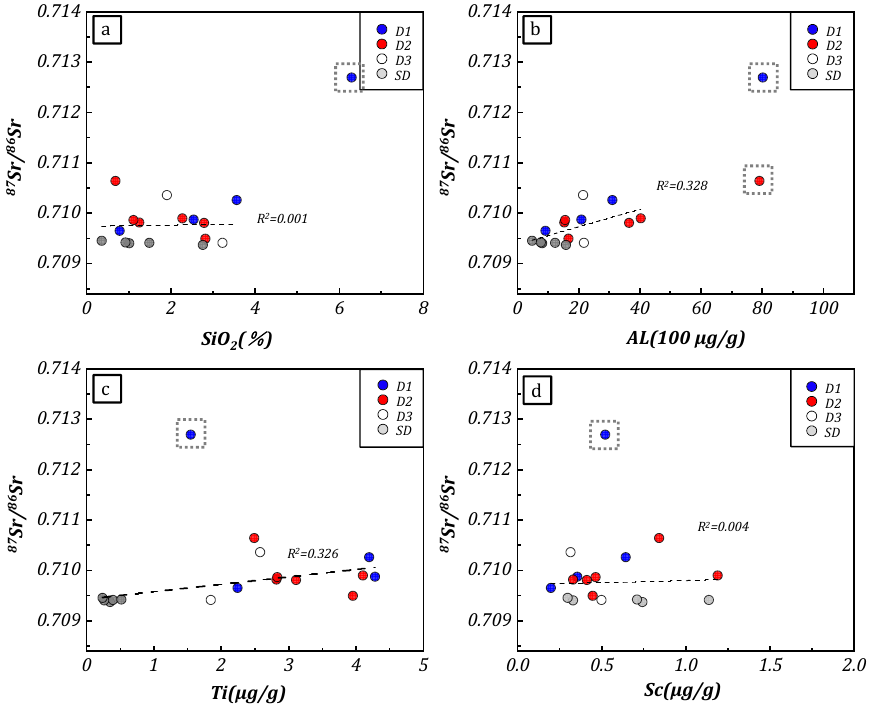
Figure 10. Cross-plot of ( a ) SiO 2 concentration, ( b ) Al concentration, ( c ) Ti concentration, and ( d ) Sc concentration with 87 Sr/ 86 Sr ratio of the investigated Xixiangchi dolomites. The data in the grey dashed box were not used for correlation analysis.